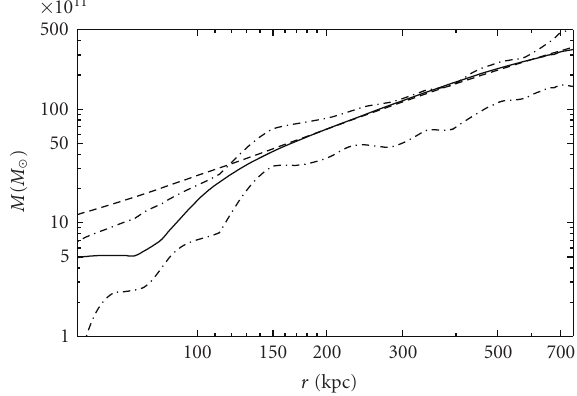
Figure 8: As an example of the above results, we have plotted the baryonic mass vs radii for Abell A133. Dashed line is the experimental-observed estimation (141) of baryonic matter com- ponent (i.e., gas, galaxies and cD-galaxy); solid line is the theoretical estimation (140) for baryonic matter component. Dotted lines are the 1- σ confidence levels given by errors on fitting parameters plus statistical errors on mass profiles as discussed in Section 11.4 in the right panel.